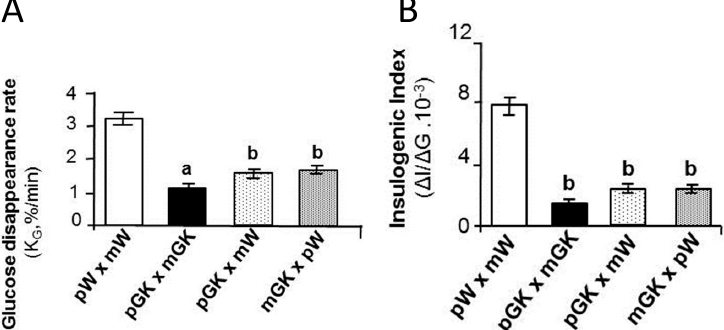
Figure 3. Metabolic and endocrine phenotypes of young male rats issued from crosses (F1) between normal Wistar (mW) or diabetic (mGK) mothers and normal (pW) or diabetic (pGK) fathers. Indices of glucose tolerance (rate of glucose disappearance, K G ), after an in vivo glucose charge) ( A ), and of insulin secretion (insulinogenic index, ∆ I/ ∆ G), in response to an in vivo glucose charge ( B ), have been evaluated. (a) p < 0.01 versus pW/mW, pGK/mW and mGK/pW. (b) p < 0.001 versus pW/mW and pGK/mGK. Adapted from [108]. The Goto-Kakizaki (GK) rat is one of the best characterized animal models of spontaneous type 2 diabetes (T2D) model. It has provided new insights into the